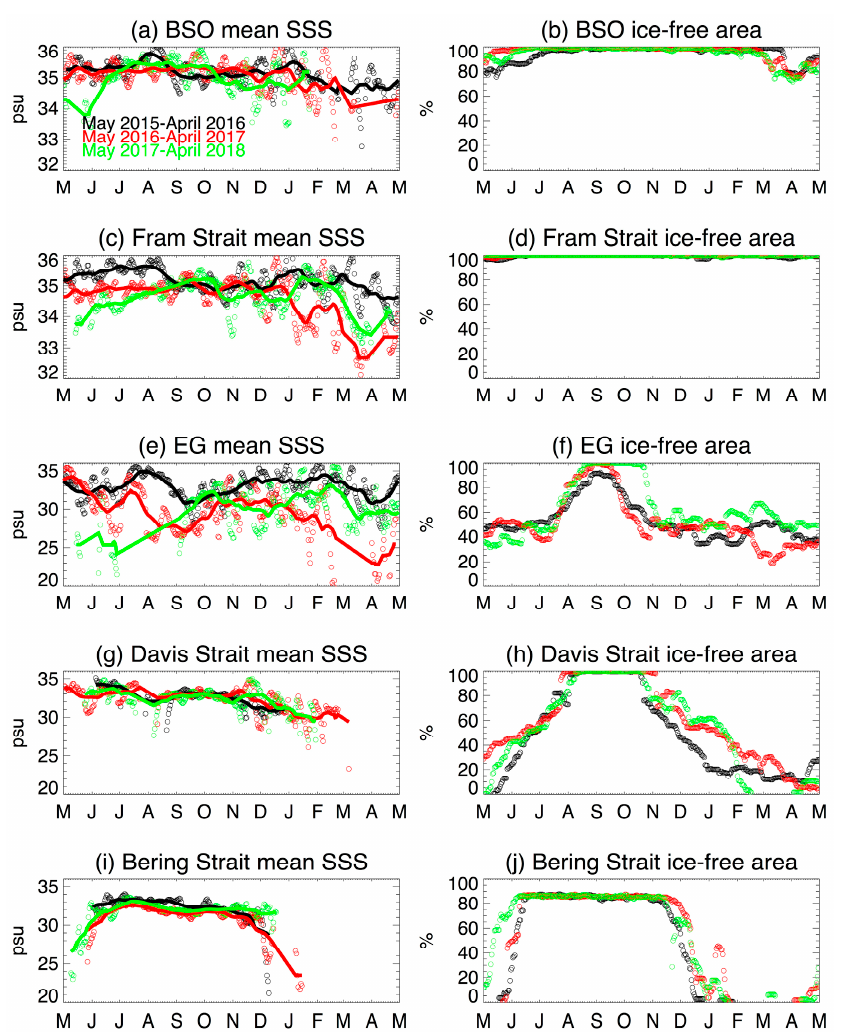
Figure 10. Time series at Arctic Ocean gateways of 1 May 2015–30 April 2016 (black), 1 May 2016–30 April 2017 (red), and 1 May 2017–30 April 2018 (green) of (left) SMAP SSS averaged and (right) percentage of the ice-free area over Arctic gateways defined in Figure 9b. ( a , b ) The Barents Sea Opening (BSO); ( c , d ) the Fram Strait east of 0 ◦ longitude; ( e , f ) the Fram Strait opening between east coast of Greenland and Svalbard (EG); ( g , h ) the Davis Strait; and, ( i , j ) the Bering Strait. 30 days moving average is applied on SSS time series (left column, thick lines).